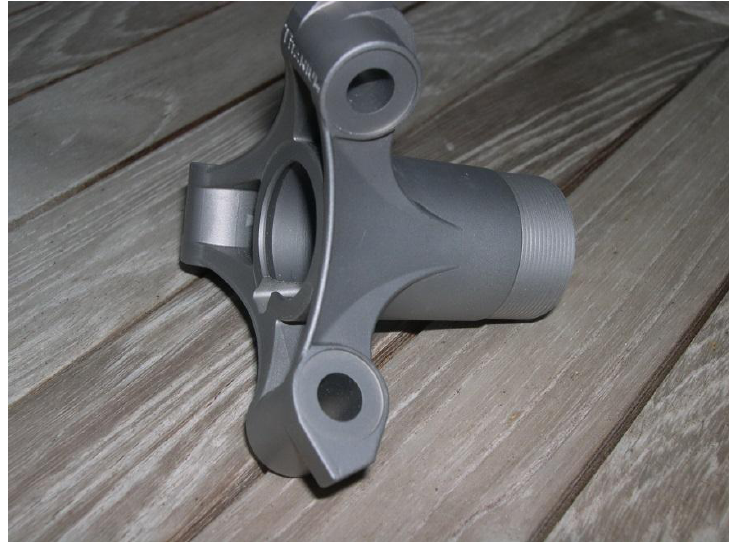
Figure 2. An example of a Ti-MIM component, in this case a tripod